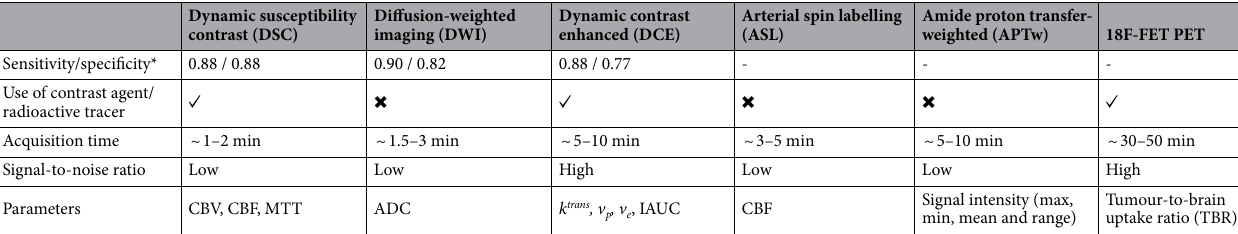
Table 3. A comparison of each included method. * Based on computed subgroup